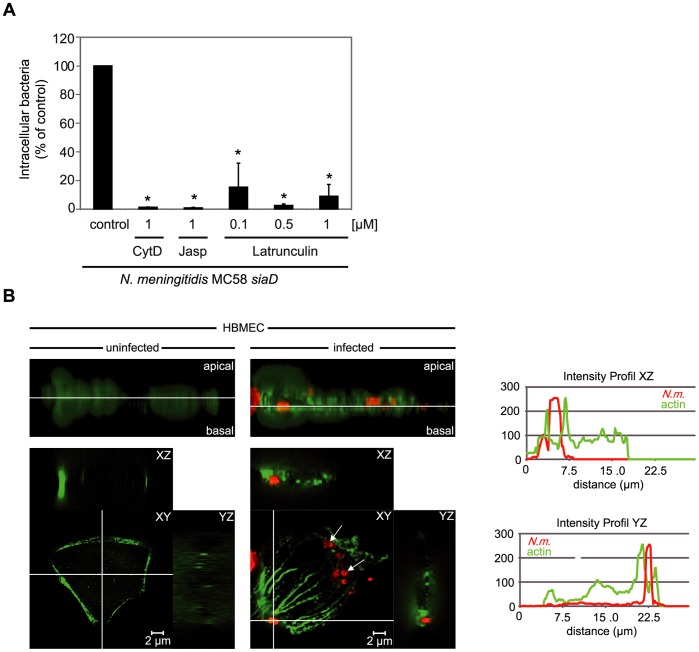

N. meningitidis internalization by HBMEC requires actin cytoskeleton dynamics.(A) HBMEC were pre-incubated with indicated concentrations of inhibitors of the cytoskeleton, including cytochalasin D (Cyt D, 1 µM), jaspakinolide (Jasp), Latrunculin or solvent (DMSO) as a control and infected for 8 h with the unencapsulated invasive strain N. meningitidis strain MC58 siaD. Intracellular bacteria were defined by gentamicin protection assay. The graph shows mean values +/− S.D. of three independent experiments done in duplicate. * P<0.05, relative to cells infected without inhibitor. (B) Immunofluorescence analysis of HBMEC infected with N. meningitidis for 4 h. Uninfected and infected cells were fixed and labeled with Alexa Fluor® 488 phalloidin (green fluorescence). Bacteria were immunostained with a rabbit anti-meningococcal serum and secondary TRITC-labelled goat α-rabbit IgG (red fluorescence). The upper panels represent the z-stack projections, the white lane marks the level of the xy-planes shown in the lower panels. Meningococci attached to HBMEC induced an increase of actin concentration and caused the formation of actin stress fibers, consisting of long bundles of filaments traversing the cell, whereas uninfected control cells showed no formation of stress fibers. Internalized bacteria are marked with arrows. Fluorescence signals were separately quantified in the GFP and rhodamin channels and showed an increase in the local concentration of actin adjacent to the attached bacterium. Figure shows an X–Y plan view and the X–Z and Y–Z sagittal cross-sections. Scale bar  = 2 µm.